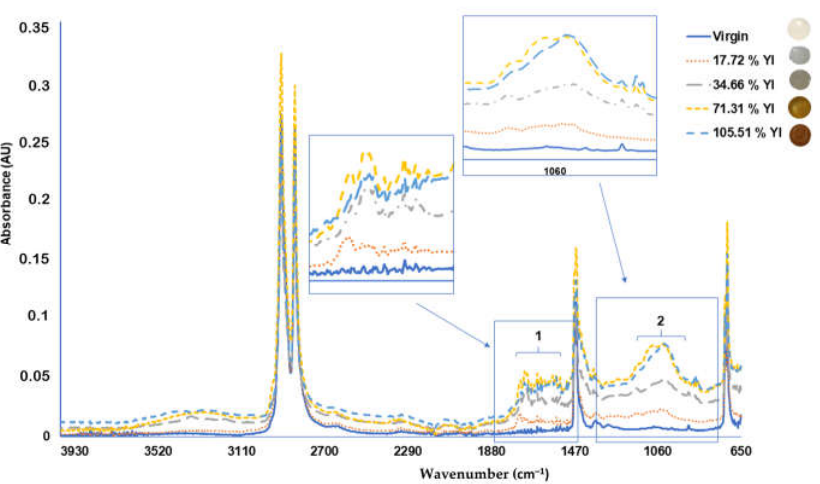
Figure 4. Polyethylene (PE) pellet FTIR-ATR spectrum with different Yellowness Index value; ( 1 ) PE oxidation with C = O; C = C bonds; ( 2 ) PE oxidation with C-O-C bonds.